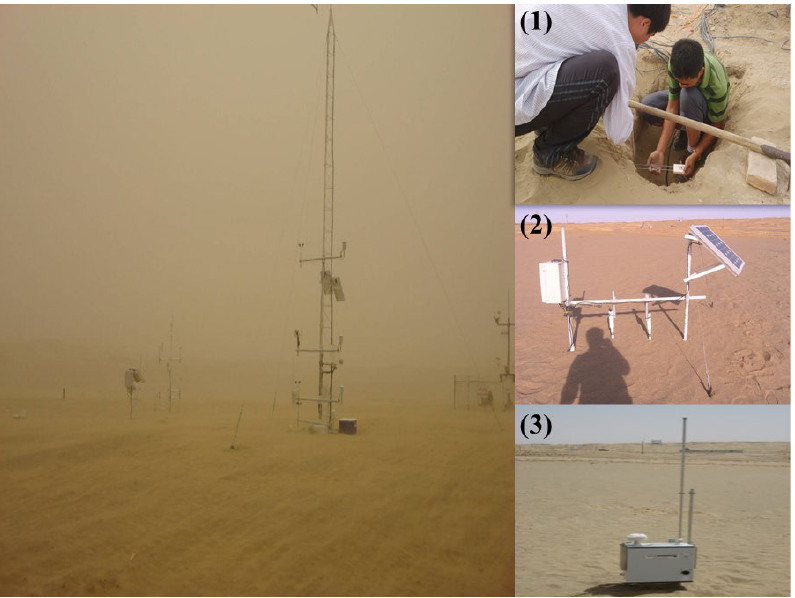
Figure 2. Overview of the entire experimental ground. ( 1 ) Soil moisture gauge. ( 2 ) Piezoelectric saltation sensor. ( 3 ) Grimm model 1.108.